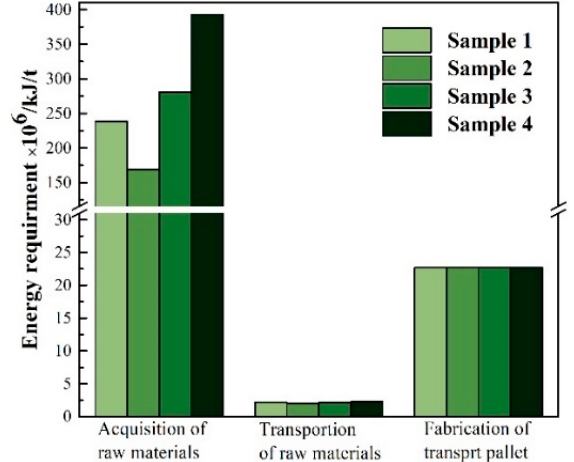
Figure 5. Energy demand for one ton of the PLA-based WPCs.